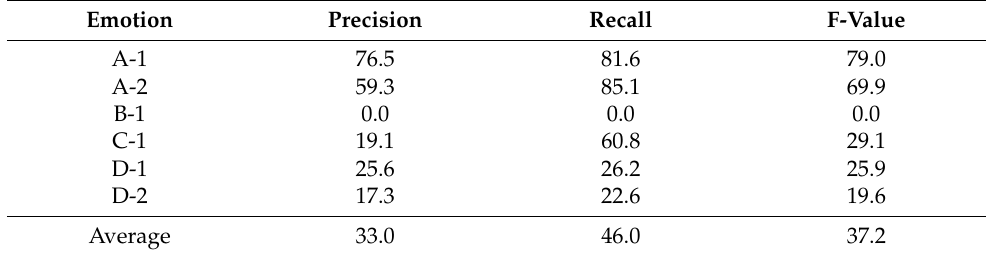
Table 11. Experimental results of emotion estimation (Model-1). Emotion